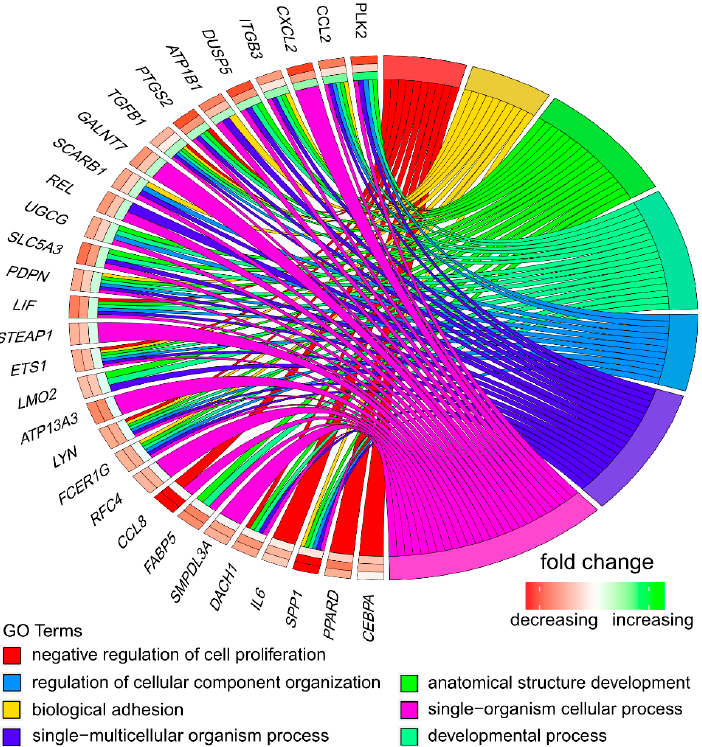
Figure 5. The representation of the mutual relationship of differently expressed genes that belongs to genes from anatomical structure development, biological adhesion, developmental process, negative regulation of cell proliferation, regulation of cellular component organization, single − multicellular organism process, and single − organism cellular process GO BP terms. The ribbons indicate which gene belongs to which categories. The middle circle represents logarithm from fold change (LogFC) between D15/D7, D30/D15, and D30/D15, respectively. The color of each block corresponds to the LogFC of each gene (green: Upregulated, red: Downregulated). The genes were sorted by logFC from most to least changed gene.